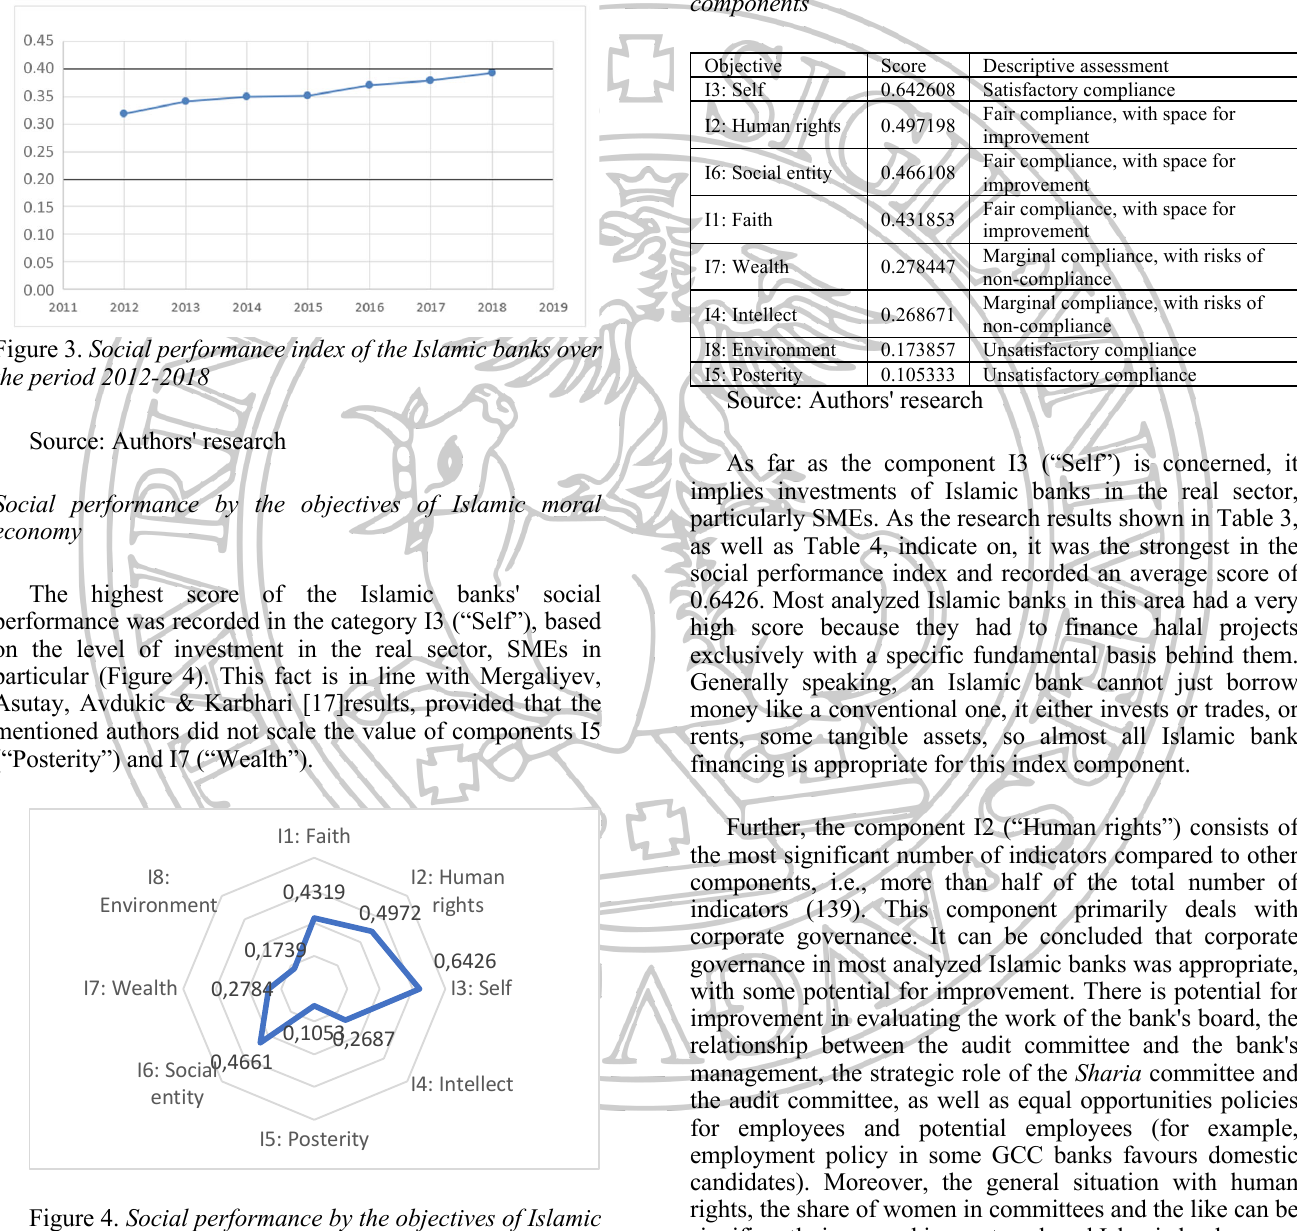
Table 3. Assessment of the banks' compliance by index